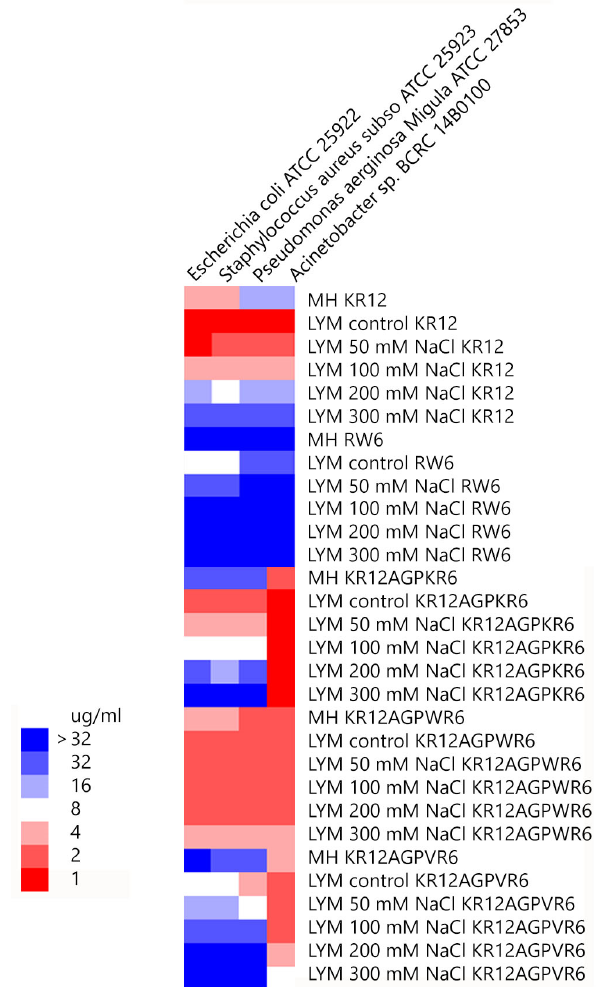
Figure 2. Minimal inhibitory concentration (MIC) values were displayed on a color scale for KR12, RW6, KR12AGPKR6, KR12AGPWR6 and KR12AGPVR6 under Mueller−Hinton (MH) broth and LYM medium with different concentrations of NaCl.